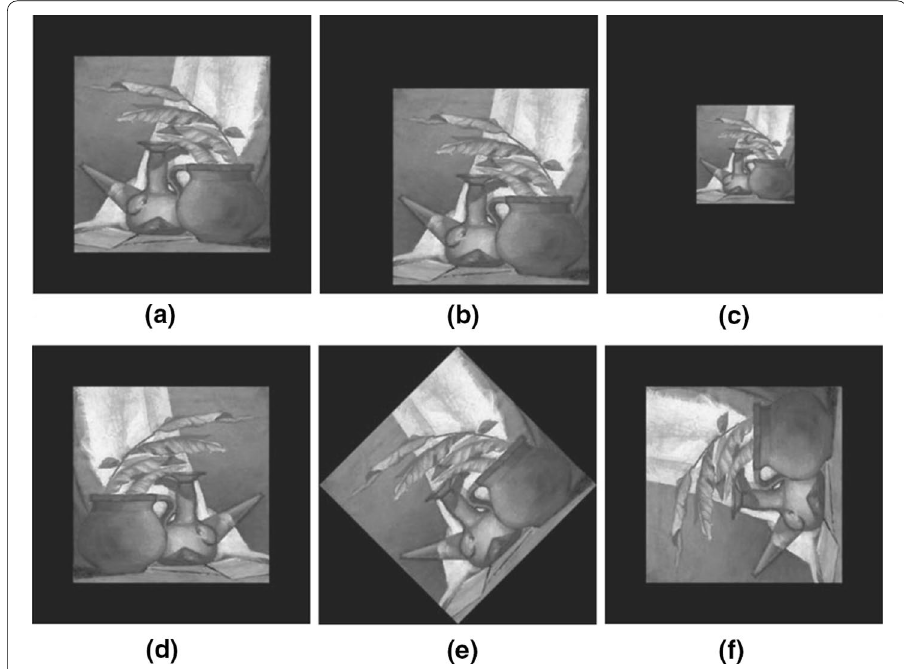
Fig. 7 The seven invariant moments for ( a ) Original image. ( b – f ) Images translated, scaled by one‑half, mirrored, rotated by 45 ◦ , and rotated by 90 ◦ , respectively. [55]